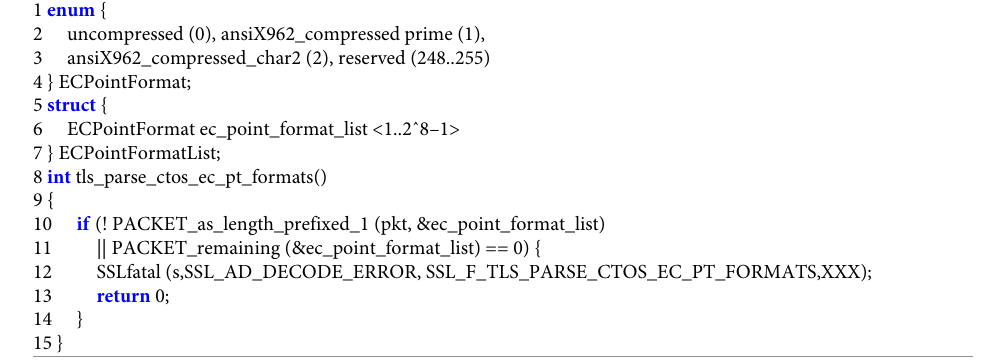
Table 6. Code for validating the ECPointFormat.